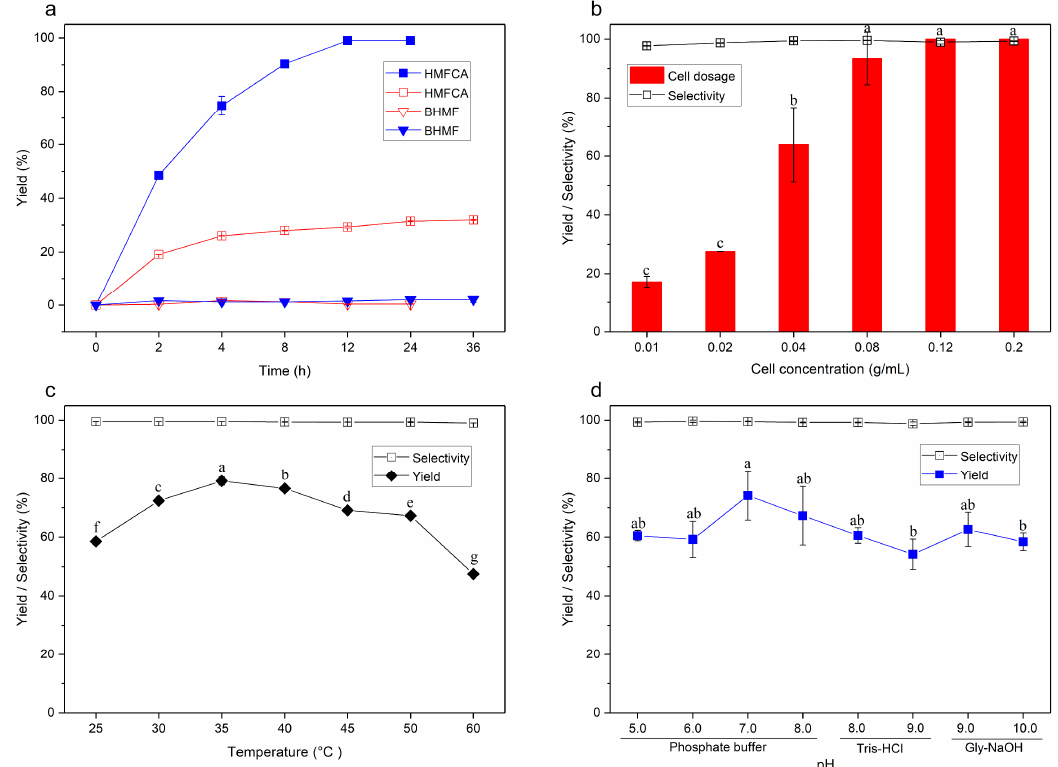
Figure 1. The influence of various factors on HMFCA synthesis by HMF. General conditions unless otherwise stated: 100 mM HMF, 0.12 g / mL microbial cells, 100 mM,pH 7.4, phosphate bu ff er, 850 rpm, 30 ◦ C, 4h reaction time. ( a ) Resting (solid symbols) and growing cells (open symbols), wherein tryptone glucose yeast extract (TGY) culture was used when growing cells were employed under 200 rpm, 30 ◦ C; ( b ) cell concentration; ( c ) temperature; and ( d )pH values. Time courses of HMF biotransformation using resting (solid symbols) and growing cells (open